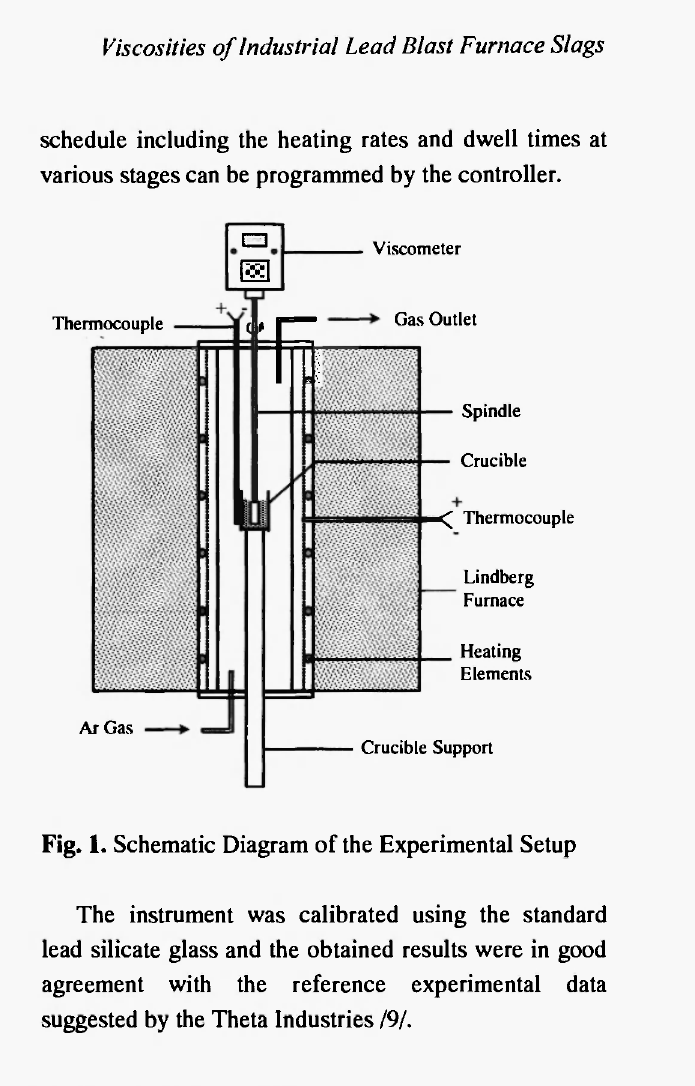
Fig. 1. Schematic Diagram of the Experimental